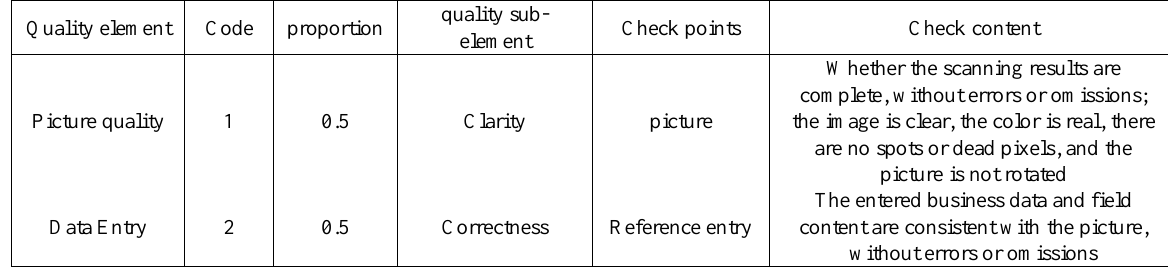
Table 2 . Contents and methods of digitization results inspection.